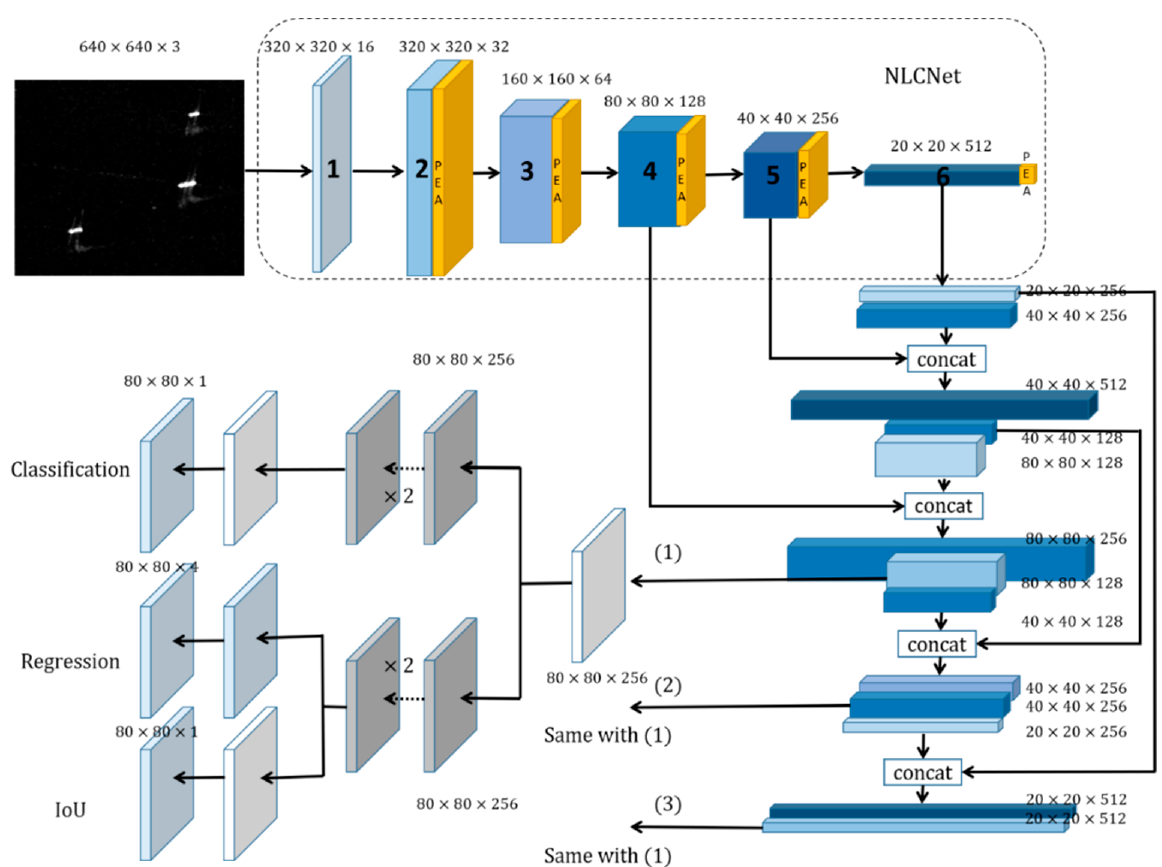
Figure 1. Overall framework of the model. PEA = position-enhanced attention. (The numbers (1–6) represent the output feature maps of blocks 1–6, respectively, and PEA is added to the adjacent blocks. The subsequent operations of (2), (3) are the same with (1).)